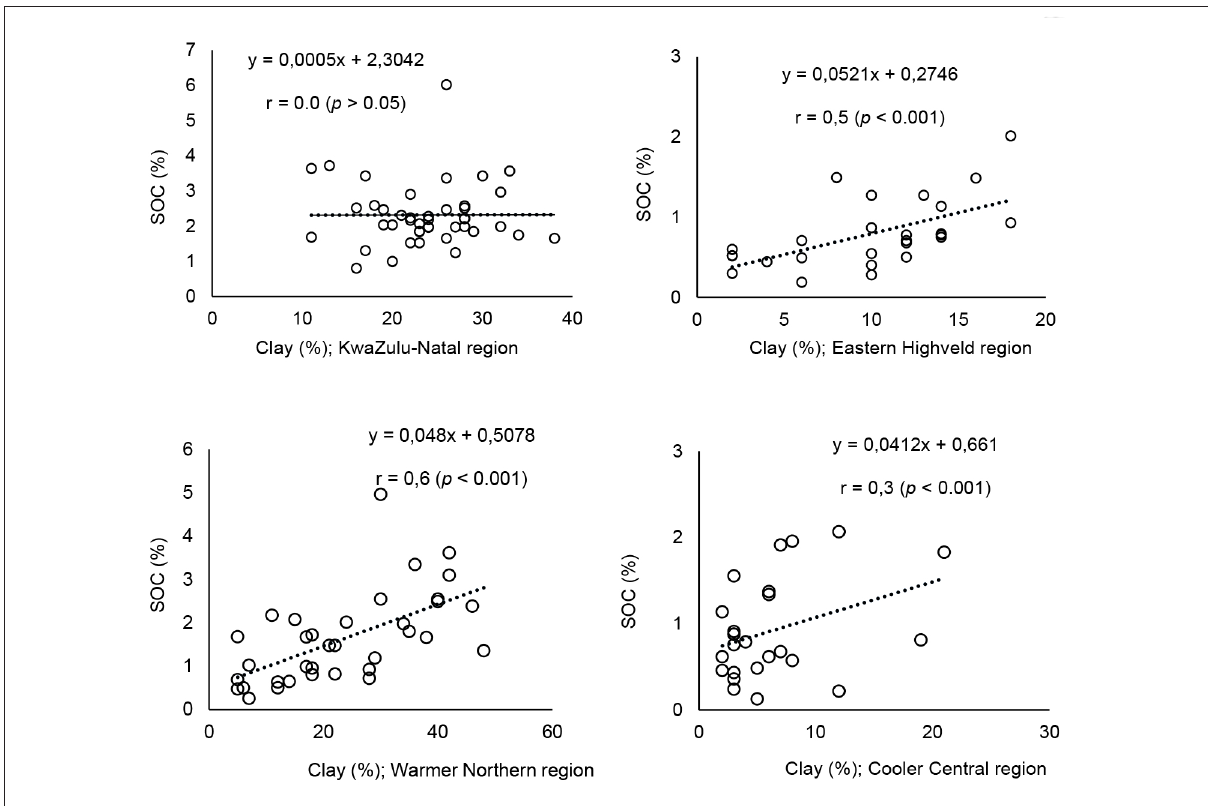
Figure 4 : The relationship between soil organic carbon (SOC) and clay content on irrigation wheat fields in South